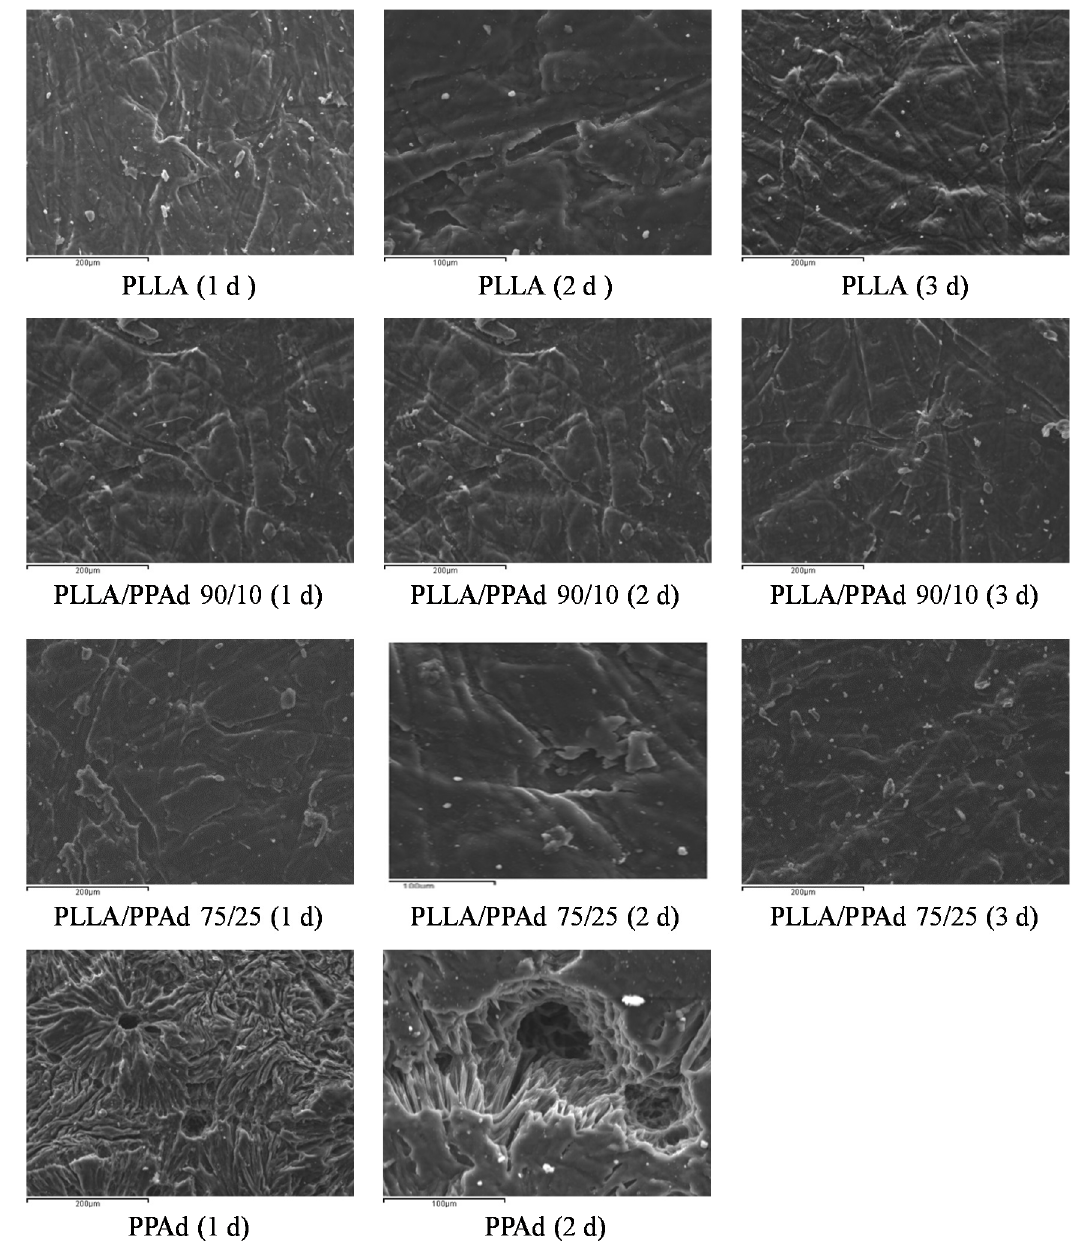
Figure 9. Scanning electron microscopy (SEM) micrographs for surfaces of enzymatic hydrolysis (1–3 days): neat PLLA, neat PPAd, PLLA-b-PPAd 90/10 and PLLA-b-PPAd 75/25 w/w .